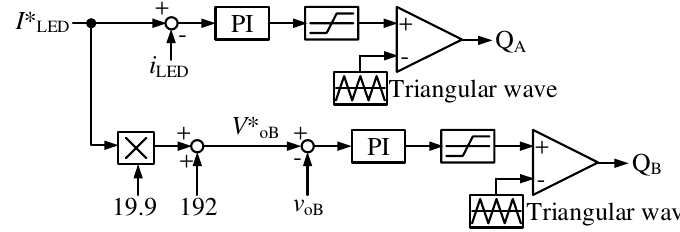
Figure 9. Control block of the proposed cooperative control